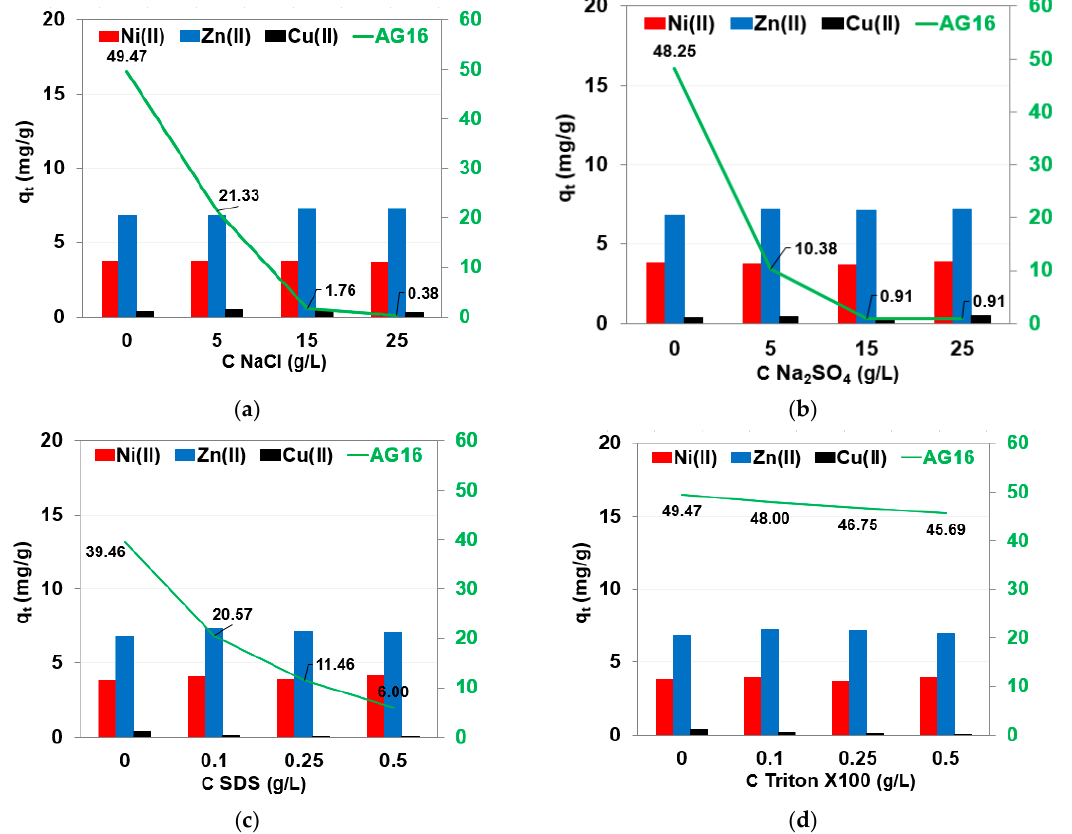
Figure 5. Effect of ( a ) NaCl, ( b ) Na 2 SO 4 , ( c ) SDS and ( d ) Triton X100 on adsorption efficiency of AG16, Ni(II), Zn(II), and Cu(II) on S5528 ( t = 15 min, AG16 C 0 = 500 mg/L; heavy metals C 0 = 100 mg/L).